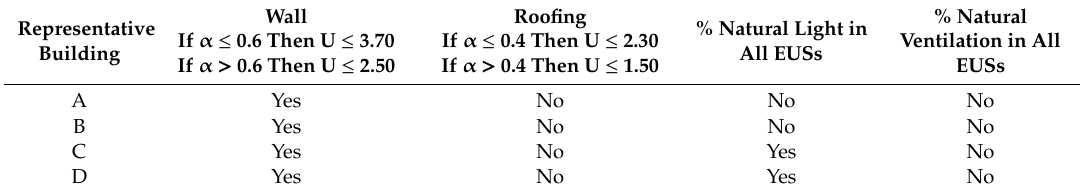
Table 4. Comparison of the conformity of representative buildings with the quality technical regulation for the energy e ffi ciency level of residential buildings (RTQ-R) requirements for bioclimatic zone (BZ) 8. Representative